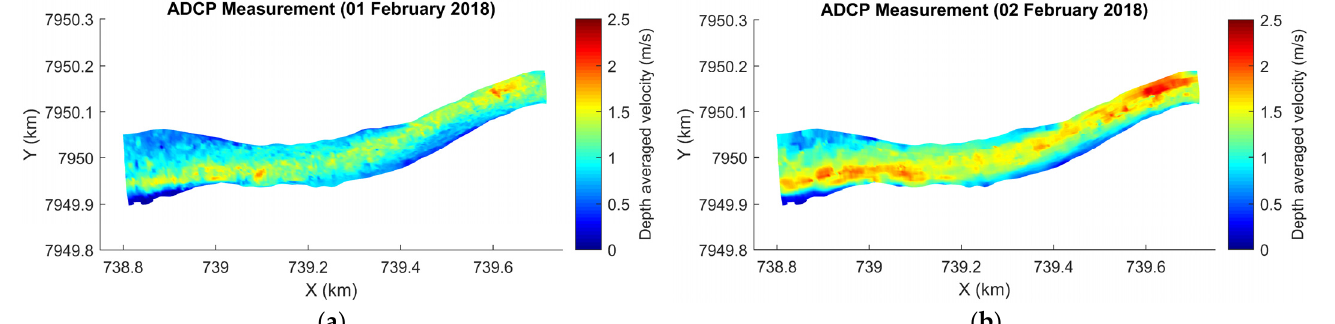
Figure 8. Depth-averaged velocities measured with ADCP and interpolated along the river reach. ( a ) 1 February 2018; ( b ) 2 February 2018. Figure 7. Flow velocity measured with ADCP at cross-section P1 on 1 February 2018. Vertical black Table 3. Measured and estimated hydraulic parameters at Taquari River, cross-section P1. lines are the positions of moving-bed tests and where bedload samples were collected. Parameters